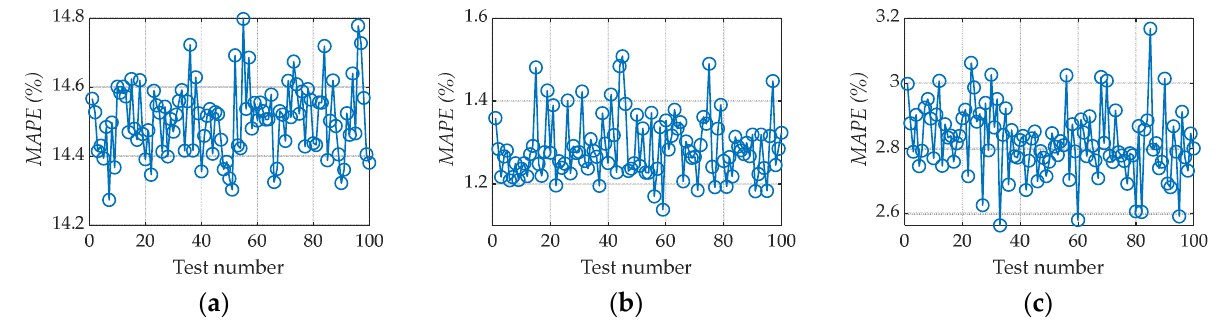
Figure 9. The comparison of precision of motor efficiency models in full working conditions. ( a ) Polynomial Regression; ( b ) Bilinear Interpolation method; ( c ) Radial Basis Kernel Function Neural Network.